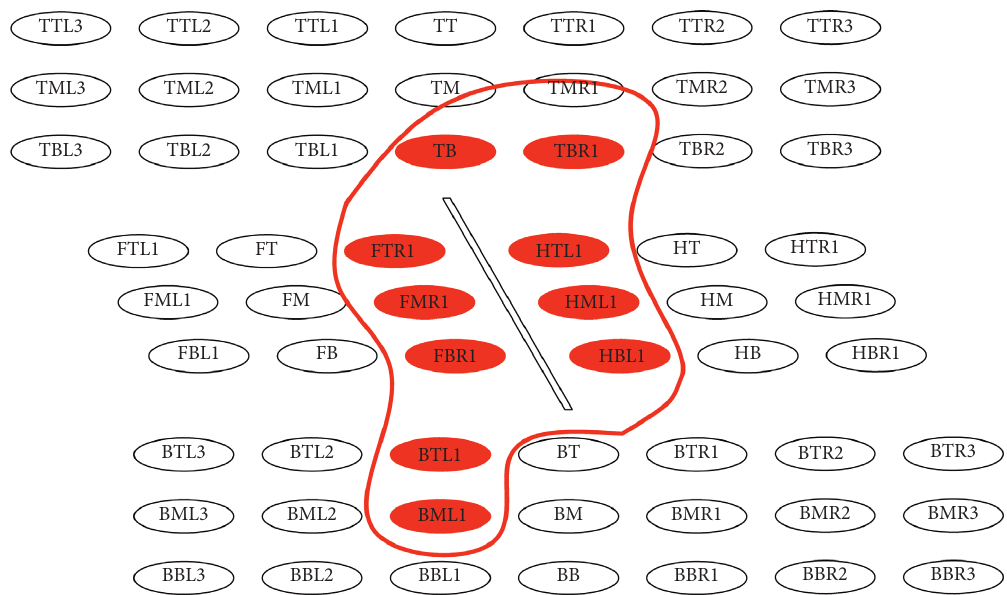
Figure 22: Hazardous injection area when injection pressure was 100MPa. Table 3: The induced maximal slippage, average slippage, and moment magnitude of fault when the pressure was